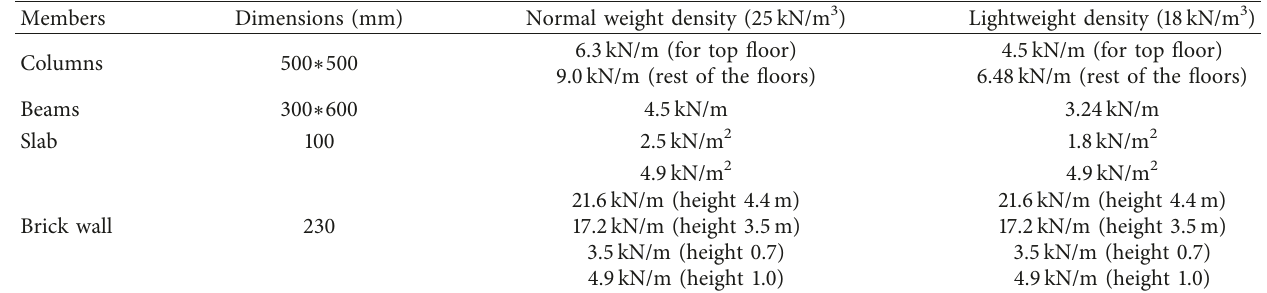
Table 2: Dead loads.